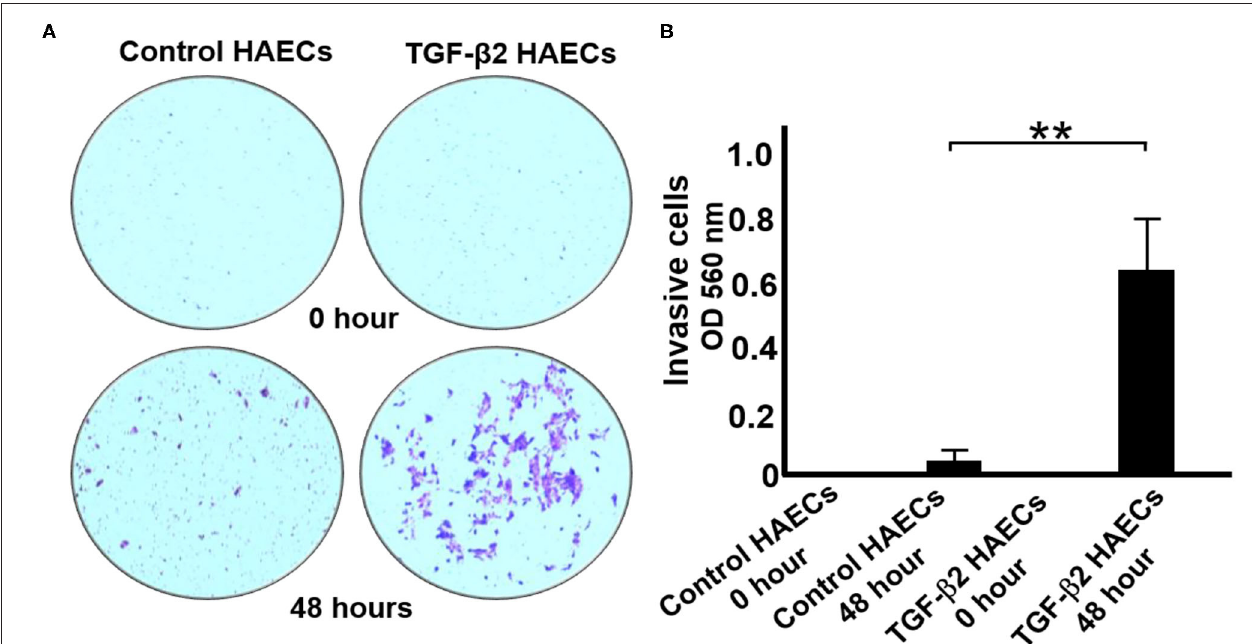
FIGURE 2 | A cell invasion assay of the effect of TGF- β 2 treatment of HAECs. (A) The comparison of invasive capabilities between control HAECs and TGF- β 2-overexpressing HAECs. Top: The cells on the bottom of the basement membrane before the invasion (0h). Bottom: The cells on the bottom of membrane after 48h of invasion. (B) The quantification of cell invasion assays in (B) . n = 3, ** P <